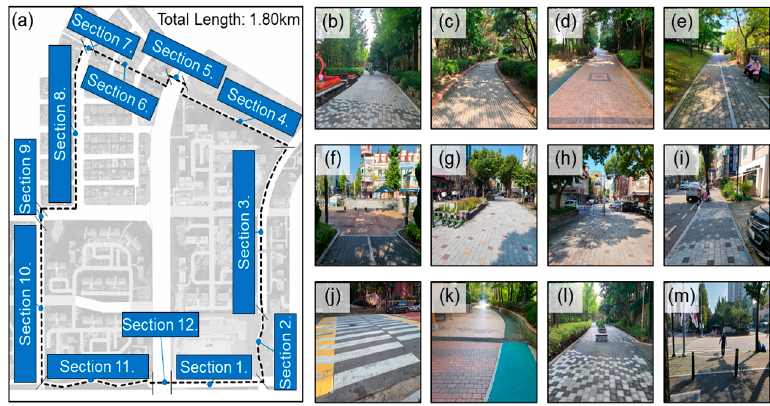
Figure 1. Overview of experimental site; ( a ) Site and sections and ( b – m ) representative pictures of each section.